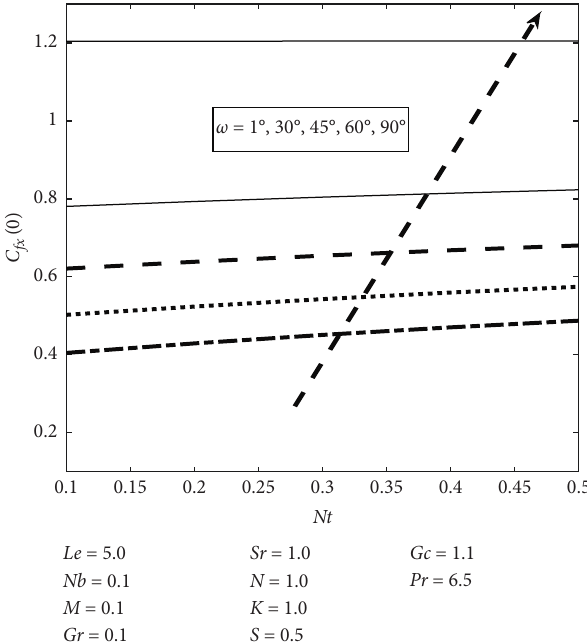
Figure 24: Variations skin friction with Nt for different values of ω .